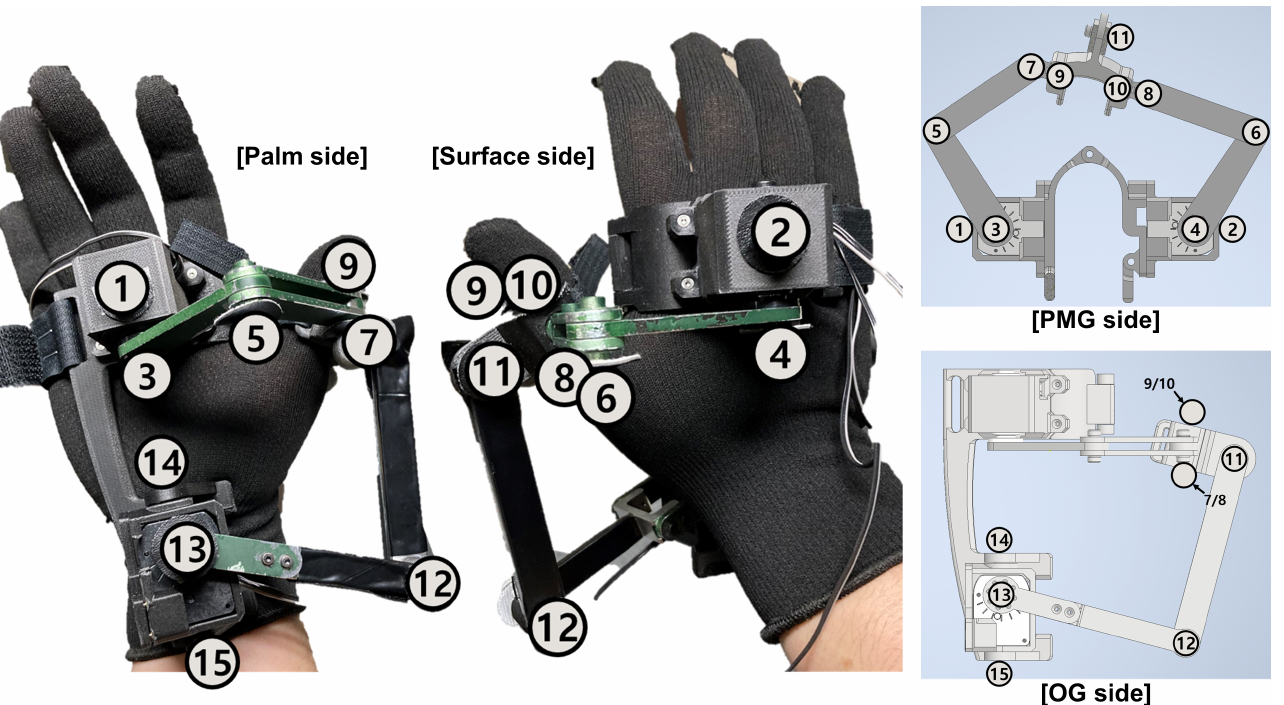
Figure 22. To improve the accuracy of the generated trajectory, the relative motion should be reduced, which will be done in future work.